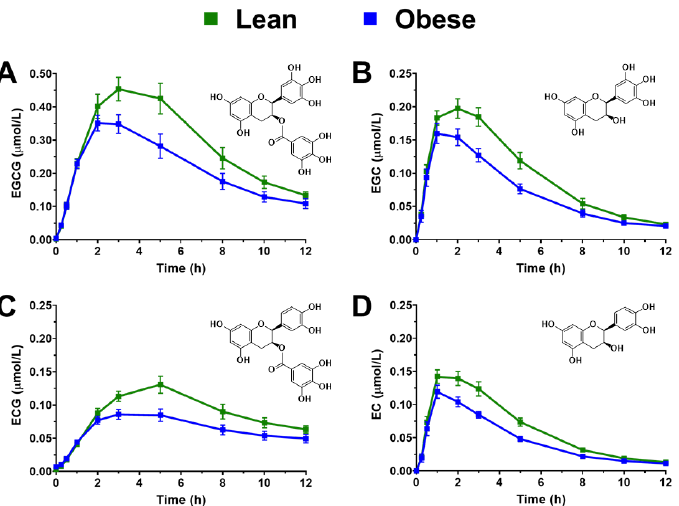
Figure 1. Plasma concentrations (means ± SEM) of ( A ) EGCG, ( B ) EGC, ( C ) EC, and ( D ) ECG in lean and obese persons ( n = 17–19 per group) after oral ingestion of a GTE-rich confection containing 290 mg EGCG, 87 mg EGC, 39 mg EC, and 28 mg ECG. Abbreviations: EC, epicatechin;